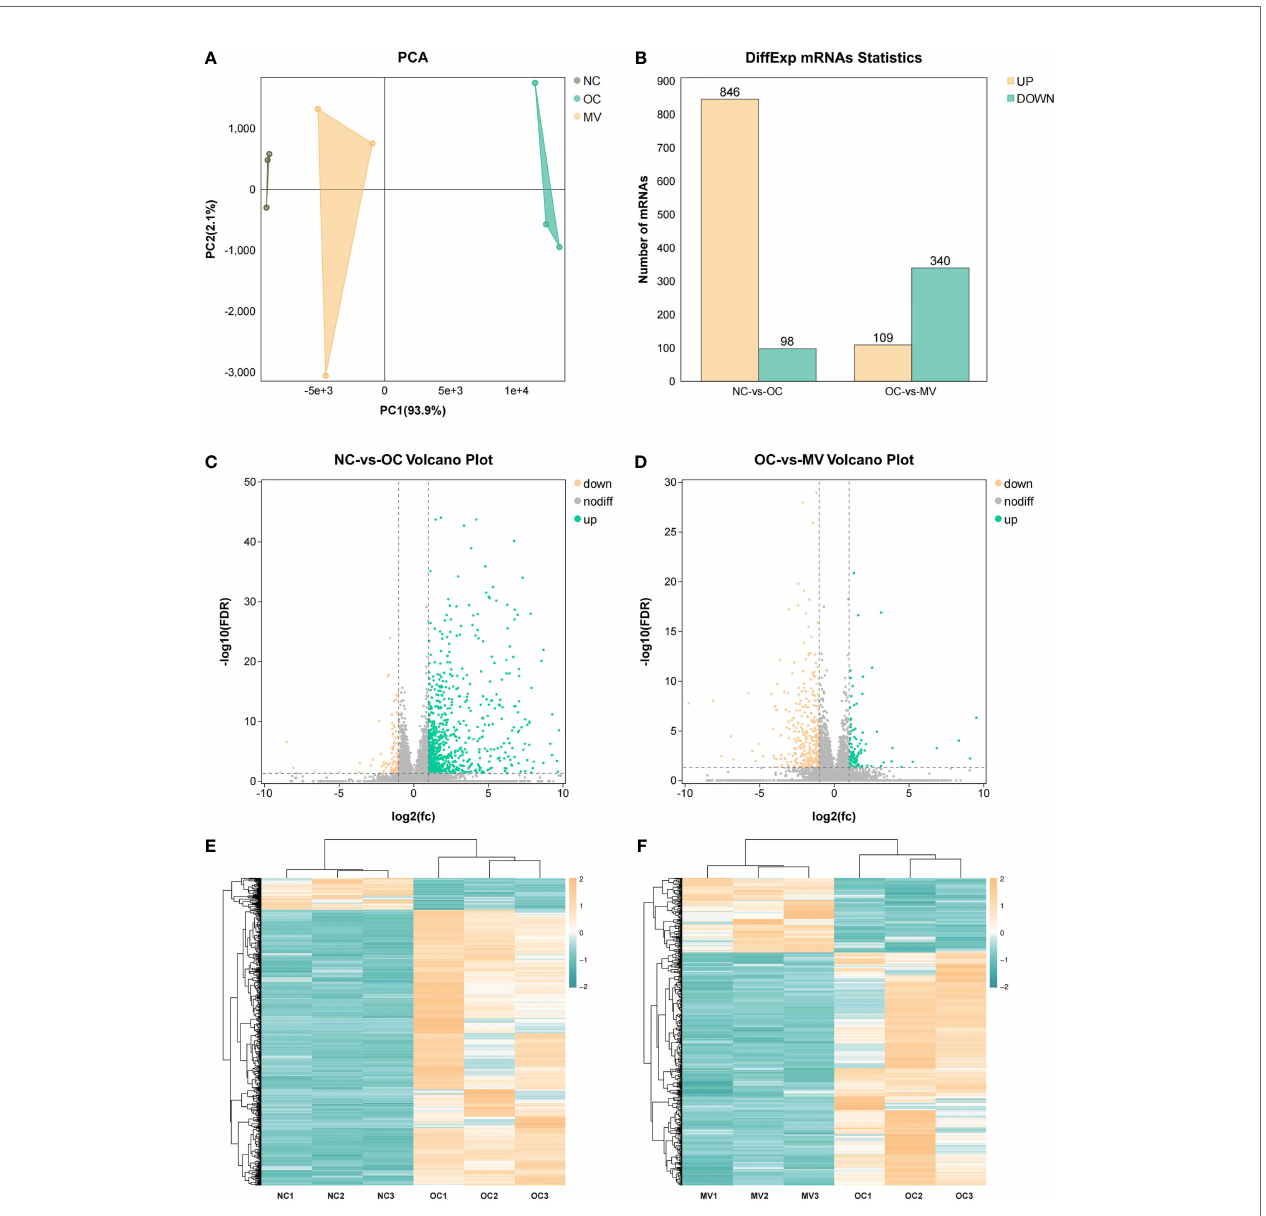
FIGURE 3 | Differential analysis in mRNA expression levels between the normal control group or the group treated with 50 mg/kg mogroside V and the lungs of the ovalbumin control group. (A) Principal component analysis of RNA-seq data. The points represent biological replicates. (B) Histogram of differential gene expression among different groups. (C, D) Volcano plots showing the relative abundances of transcripts. The transcripts were considered differentially expressed at fold change >2 and with statistical signi fi cance ( p < 0.05) between groups. The gray points represent the genes in which no statistically signi fi cant differences were observed. The red points represent the downregulated genes, and the green points represent the regulated genes that were statistically signi fi cant. (E, F) Heat map of gene expression among the different